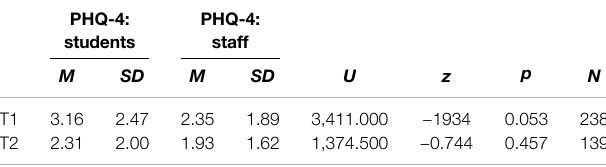
TABLE 4 | Level of psychological distress in students and staff, over time.